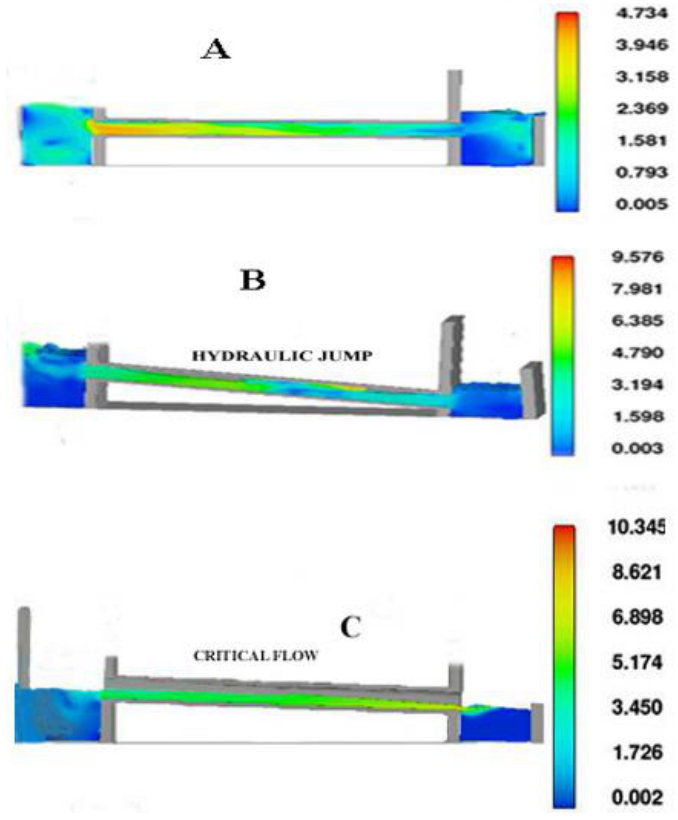
Figure 40. CFD pipeline flow characteristics for pipelines at different declination angles. Velocity is in ft/s. FLOW-3D CFD results from [2], p. 310.